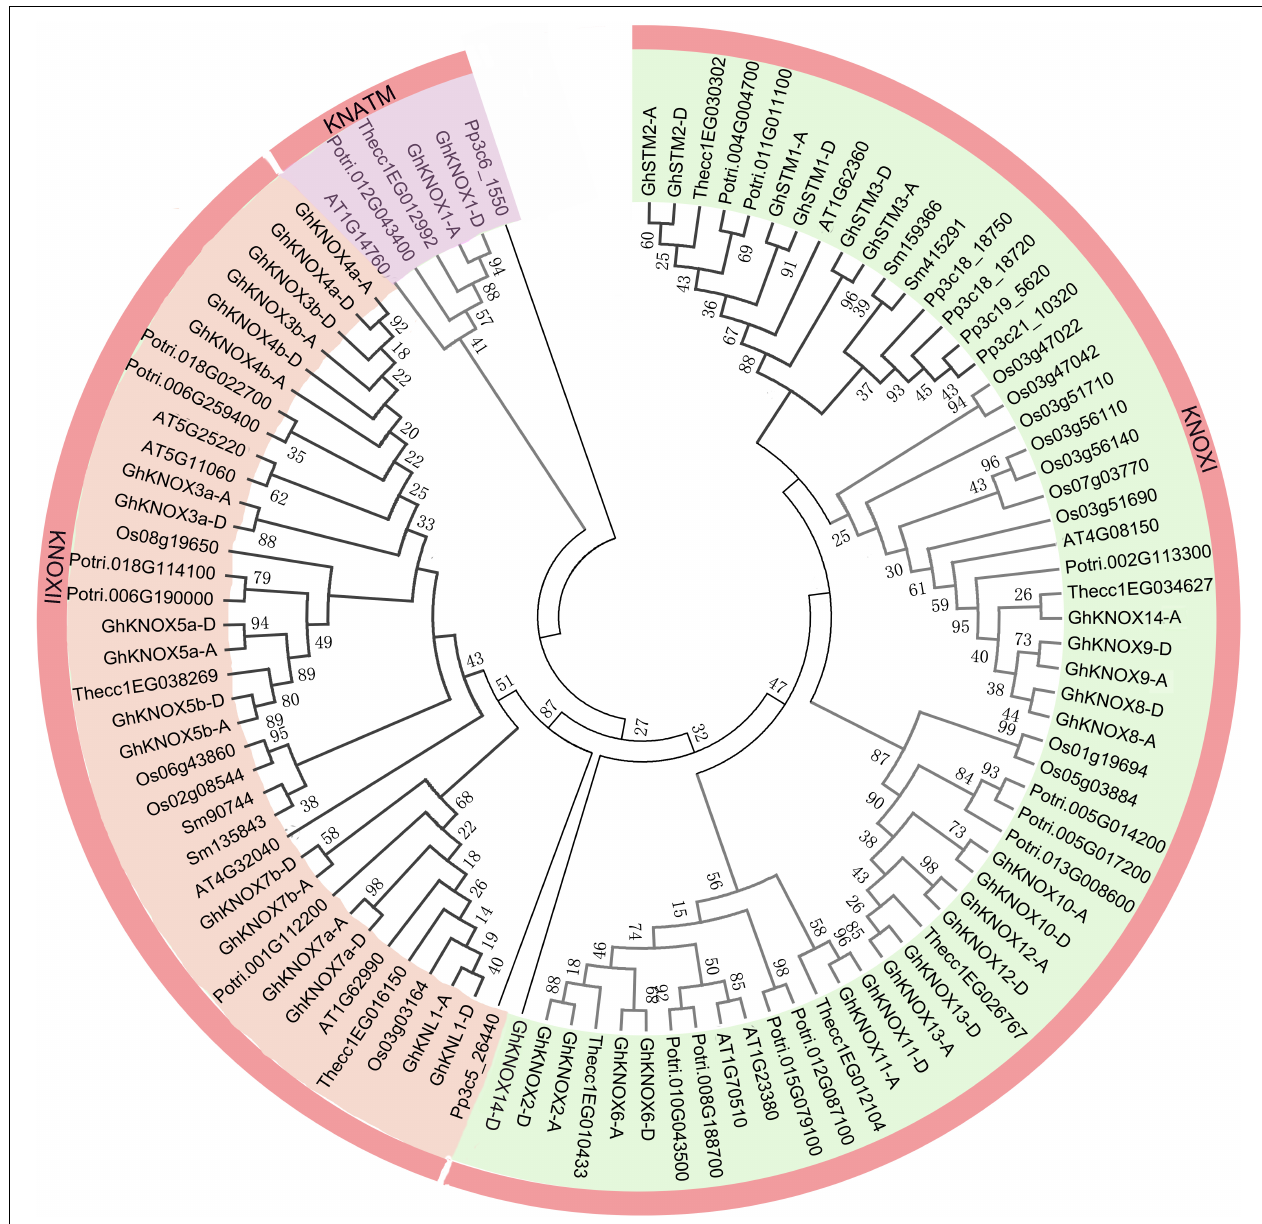
FIGURE 1 | Phylogenetic relationship of KNOX family proteins of seven species. The phylogenetic tree was constructed from KNOX amino acid sequences using the neighbor-joining method with 1000 bootstrap replicates. The inner circle is marked in purple, orange, and green representing the KNOXI, KNOXII, and KNATM clades,